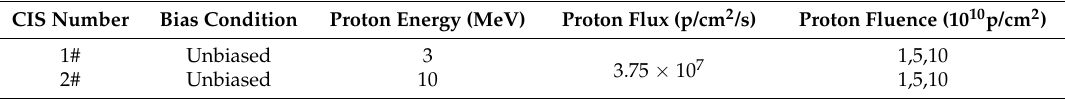
Table 1. Proton radiation experiment conditions and samples.